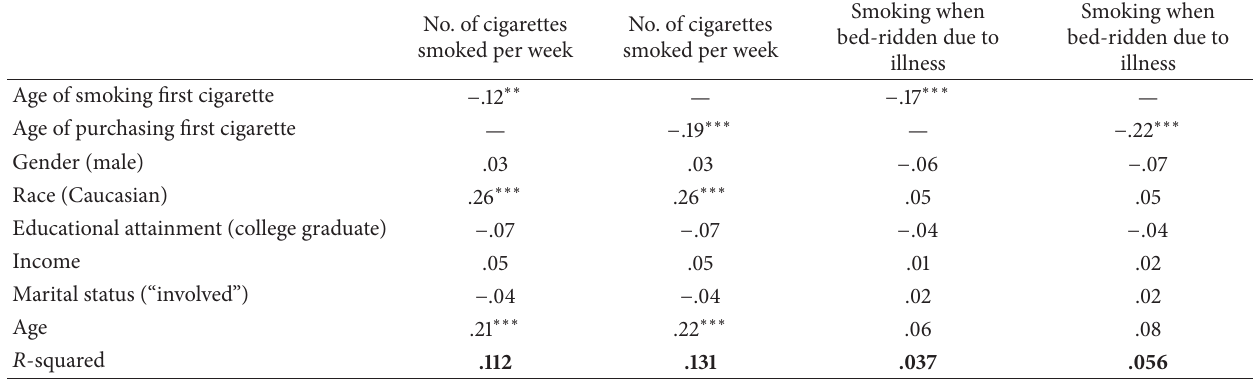
Table 2: Multivariate analysis for selected age-of-onset measures and adult smoking